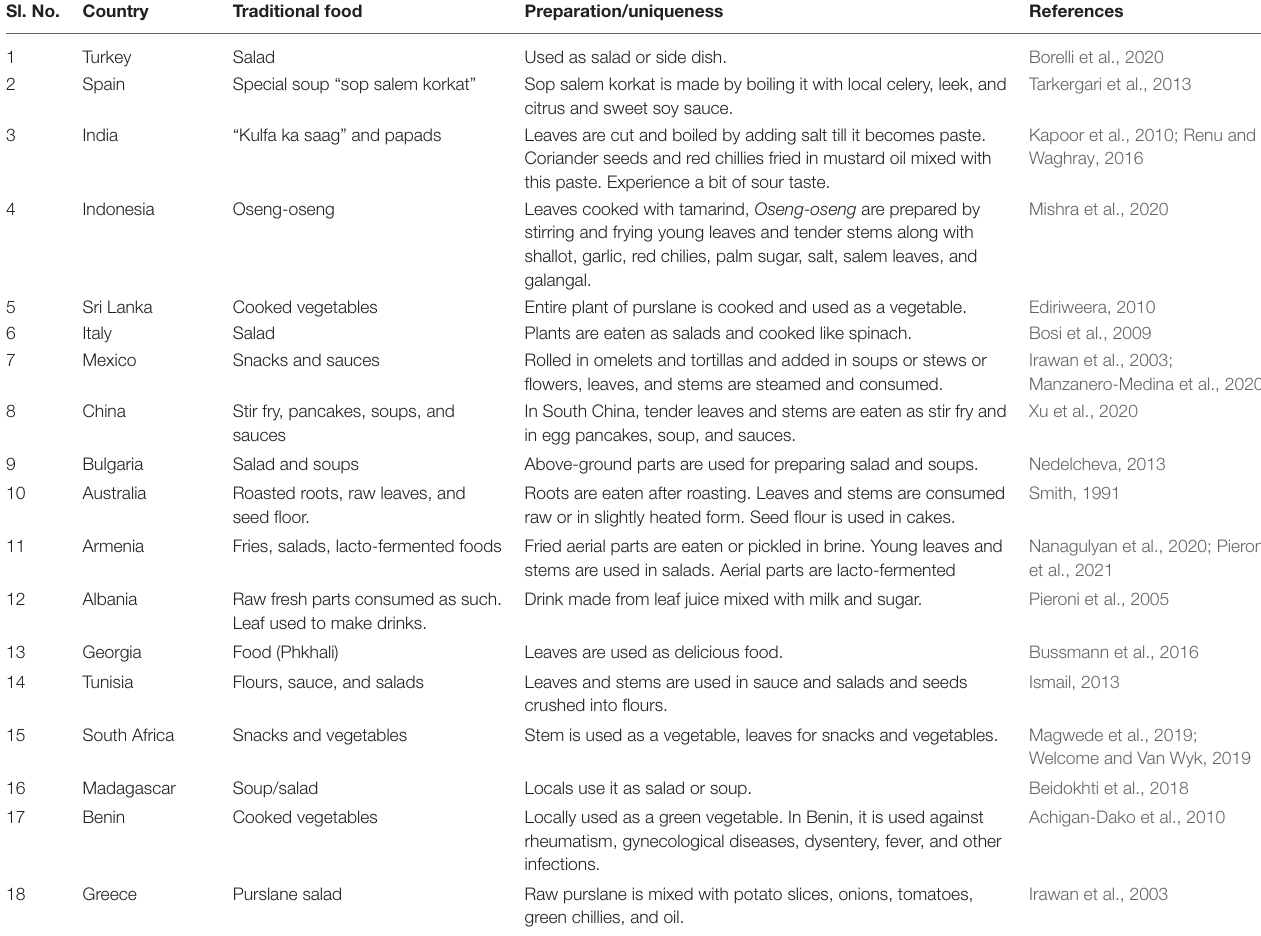
TABLE 1 | Some traditional food systems based on purslane from different countries. Sl. No.